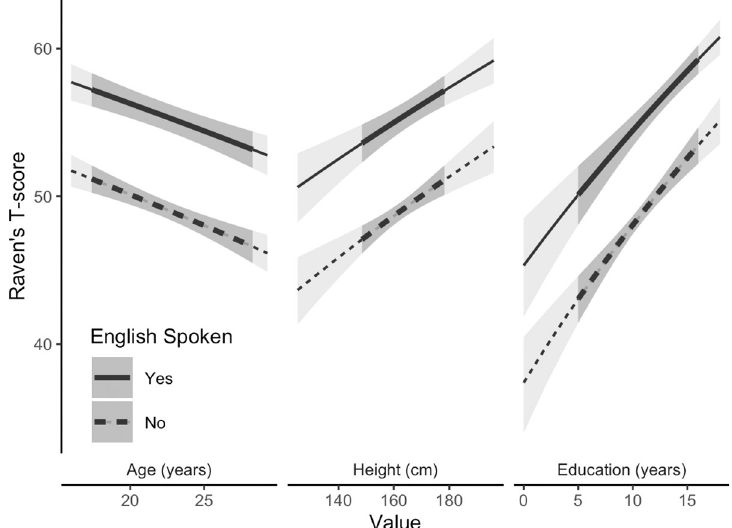
Fig 3. Direct predictors of adolescent Raven’s T score based on the structure identified in the Bayesian network. The Raven’s score is a function of the participants’ age, current height, their attained level of education, and whether they spoke English. The light grey 95% confidence intervals indicate the full range of each predictor, and the darker shading indicates the 95% confidence interval across the interquartile range of each respective predictor.